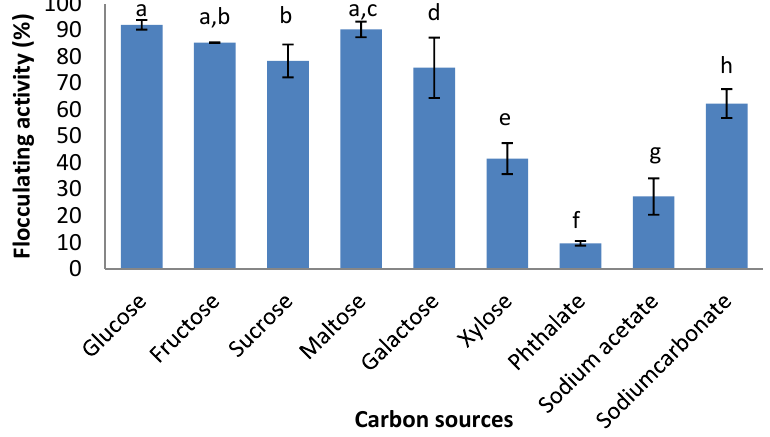
Figure 2. Effect of carbon sources on bioflocculant production of Cobetia sp. OAUIFE. Flocculating activities with different letters are significantly different ( p < 0.05) from each other.